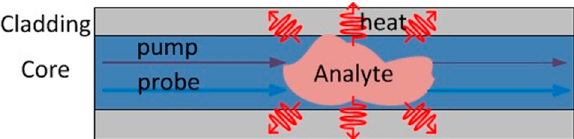
Figure 15. Distributed chemical sensing based on measurement of chemically generated heat. The wavelength of the pump chosen to coincide with the absorption line of the analyte. A small portion of the pump power is absorbed by the analyte and converted into heat; the probe reads the temperature change to detect the chemical. The weight of the line represents the optical power.